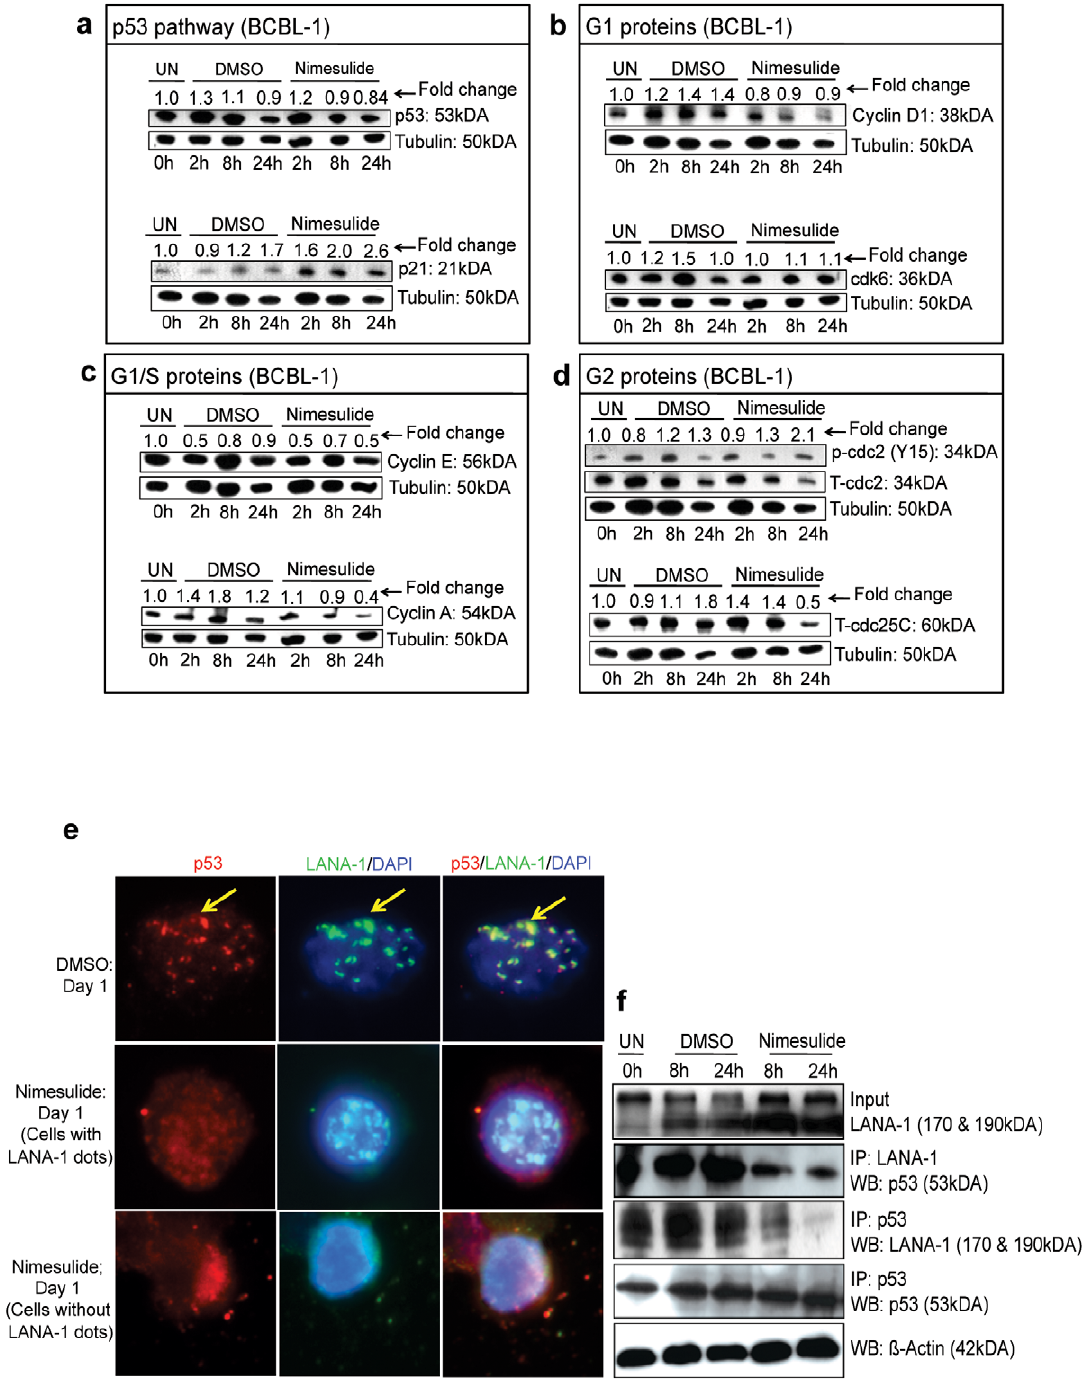
Figure 6. Effect of nimesulide on cell cycle regulatory proteins and LANA-1/p53 interaction. ( a–d ) 5 6 10 5 BCBL-1 cells were seeded with 100 m M nimesulide or DMSO. Total cell lysates were collected at 2 h, 8 h, and 24 h post-treatment and immunoblotted for p53 ( a ), p21 ( a ), cyclin D1 ( b ), cdk6 ( b ), cyclin E ( c ), cyclin A ( c ), p-cdc2 ( d ), and T-cdc25C ( d ) and normalized with respect to the tubulin loading control and T-cdc2 for the p- cdc2 blot. The cells were neither replenished with fresh media nor supplemented with the drugs. The fold change was calculated with respect to untreated (UN) cells at 0 h. ( a–d ) The data is representative of duplicate experiments. ( e ) 5 6 10 5 BCBL-1 cells were seeded with 100 m M nimesulide or DMSO and collected to examine the interaction between p53 and LANA-1 by immunofluorescence 24 h post-treatment. ( f ) Nuclear lysates isolated from BCBL-1 cells seeded with 100 m M nimesulide, DMSO or left untreated (UN) were immunoprecipitated (IP) with either LANA-1 or p53 and Western blotted (WB) with p53 and LANA-1 or p53, respectively. Level of LANA-1 in pre-IP input was assessed by Western blotting with LANA-1 antibody. b - actin was used as the loading control. ( e–f ) The cells were neither replenished with fresh media nor supplemented with the drugs.